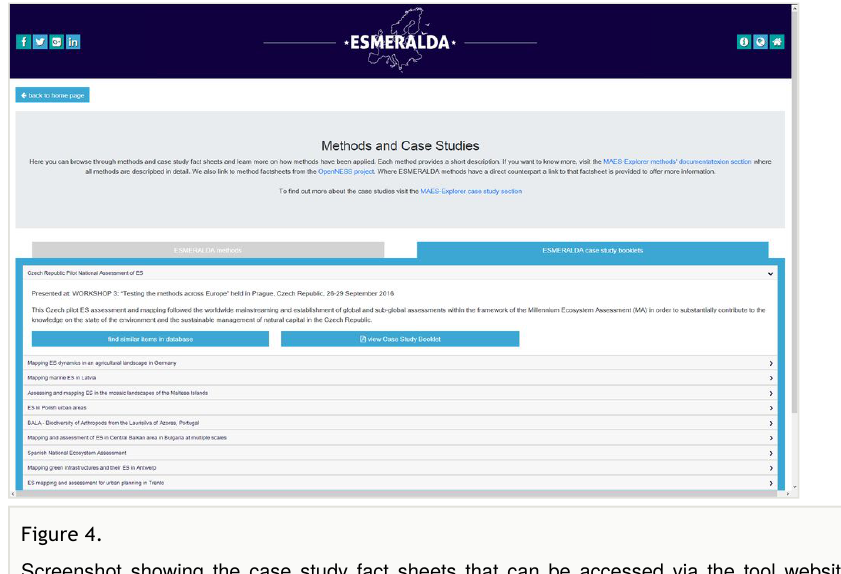
Figure 4. Screenshot showing the case study fact sheets that can be accessed via the tool website. From here, a pre-con fi gured search mask, speci fi c to the selected case-study booklet can be opened.